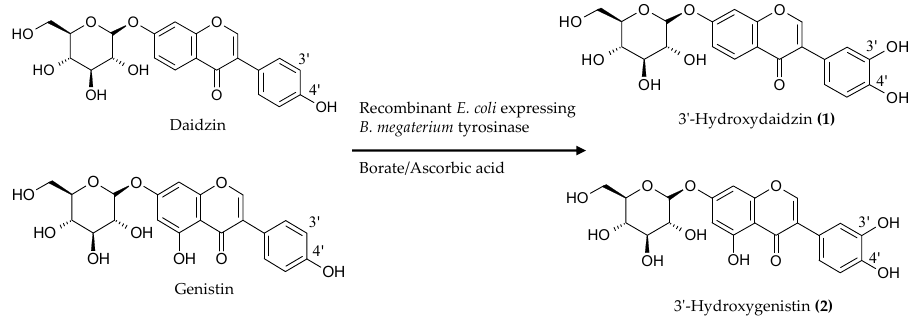
Figure 3. Diagram of the biotransformation of the soy isoflavone glycosides daidzin and genistin by the recombinant E. coli expressing B. megaterium tyrosinase.